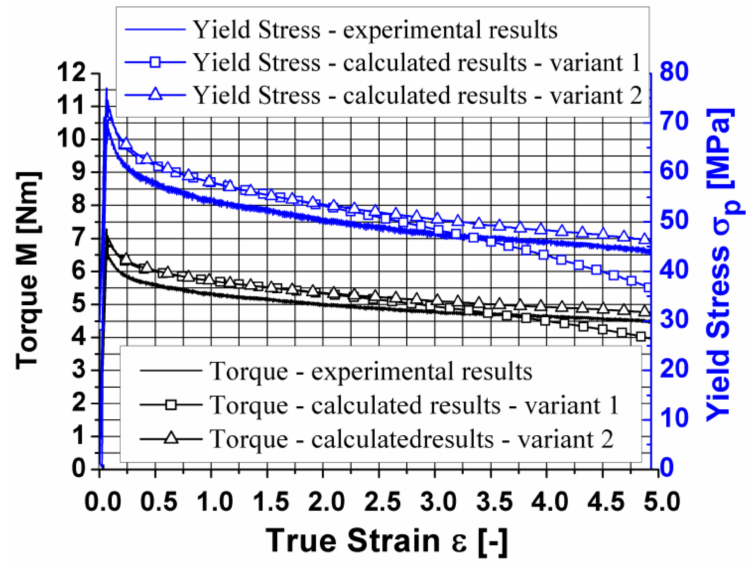
Figure 14. Changes in the torque and yield stress of the 5019 aluminium alloy—true and calcu- lated values.